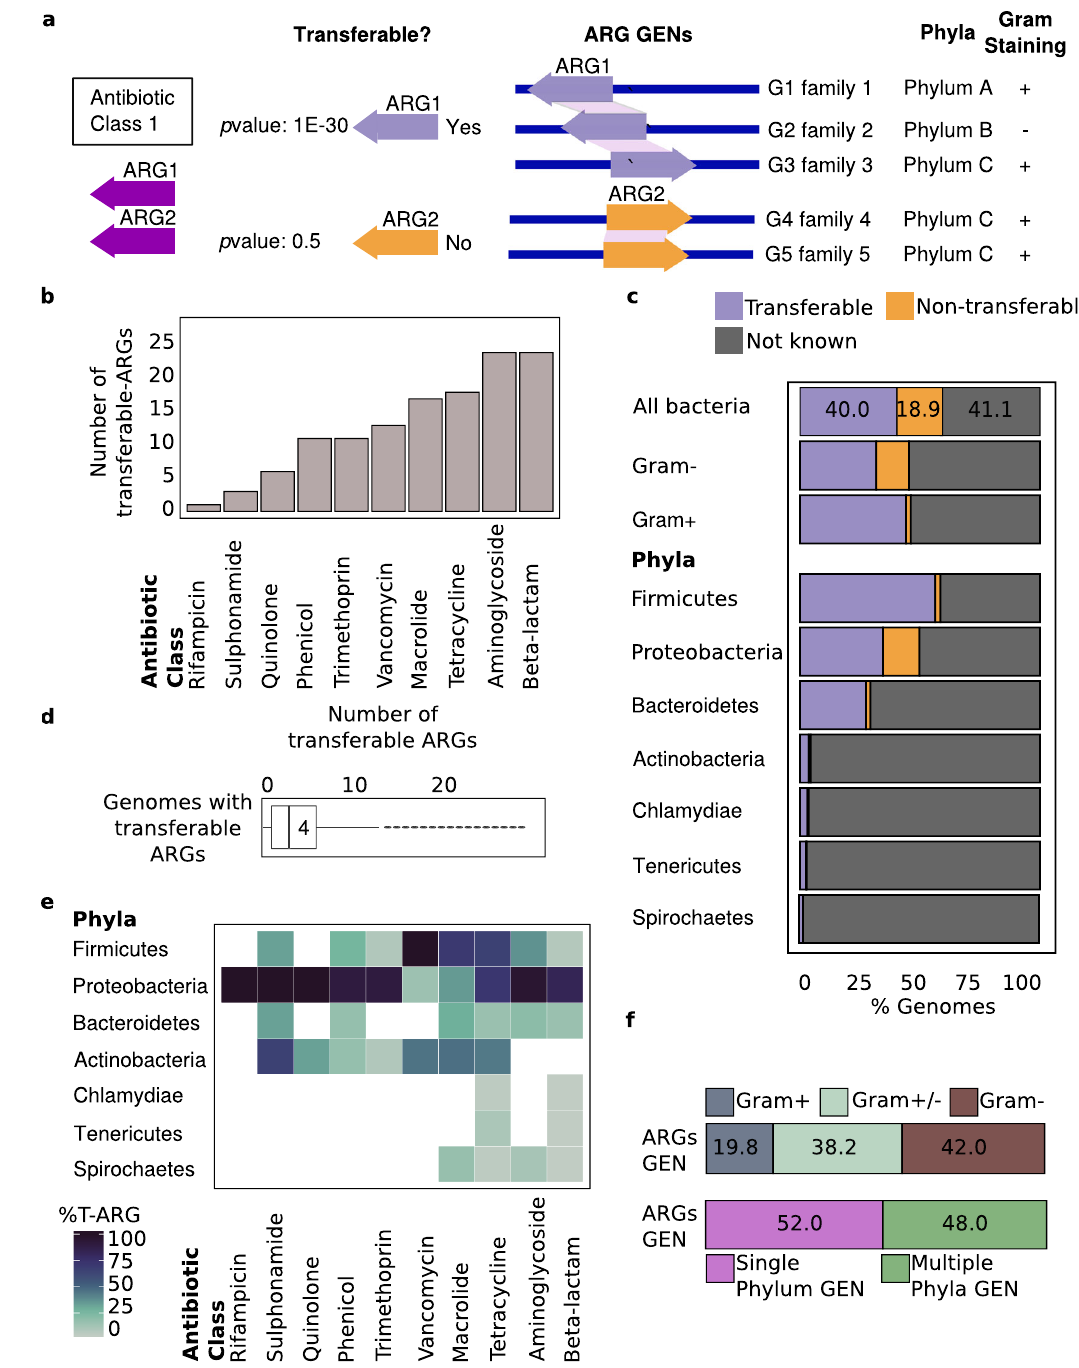
Fig. 1 Dissemination of resistance genes summarized by antibiotic class and phylum. a Conceptual guide linking antibiotic classes to phyla and gram staining through transferable ARGs and genomes in ARGs gene exchange networks (GENs). b Number of transferable ARGs per antibiotic class. c Percent of genomes in indicated phyla with transferable ARGs, nontransferable ARGS, or no known resistance genes. d Distribution of transferable ARGs across genomes. Box indicates range, line within box indicates median for all genomes, dark dots indicate outliers. e Heatmap of % transferable ARGs (T-ARGs) per antibiotic class observed for indicated phyla. f Distribution of genomes with transferable ARGs in GENs. Top, percent of GENs with Gram-negative and -positive genomes ( + / − means both). Bottom, percent of GENs with one phylum or with multiple phyla. Source data are provided in Supplementary Data 1, 2, 3, and